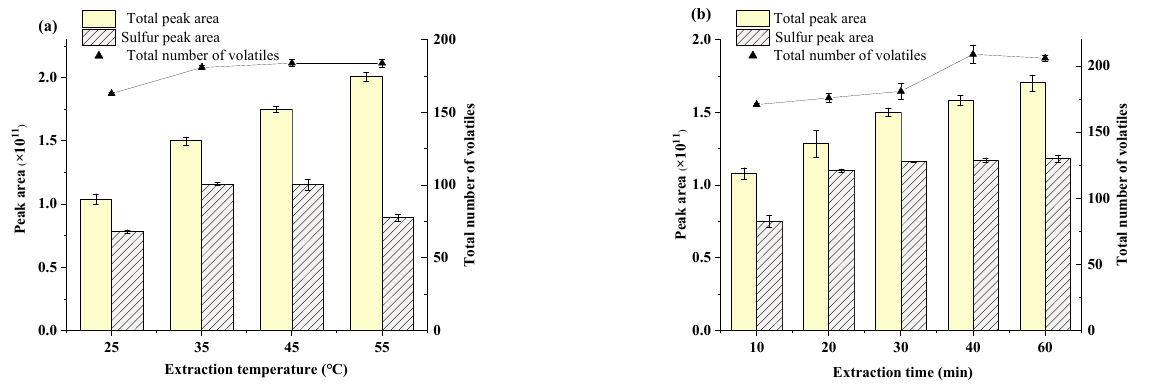
Figure 4. Effect of ( a ) extraction temperature and ( b ) extraction time on the extraction efficiency of the VOCs.